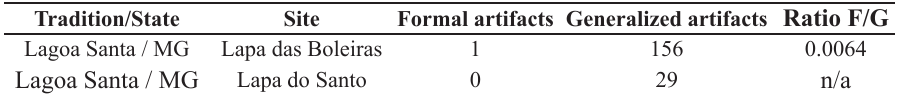
Ratios for formal to generalized (F/G) artifacts for two Lagoa Santa